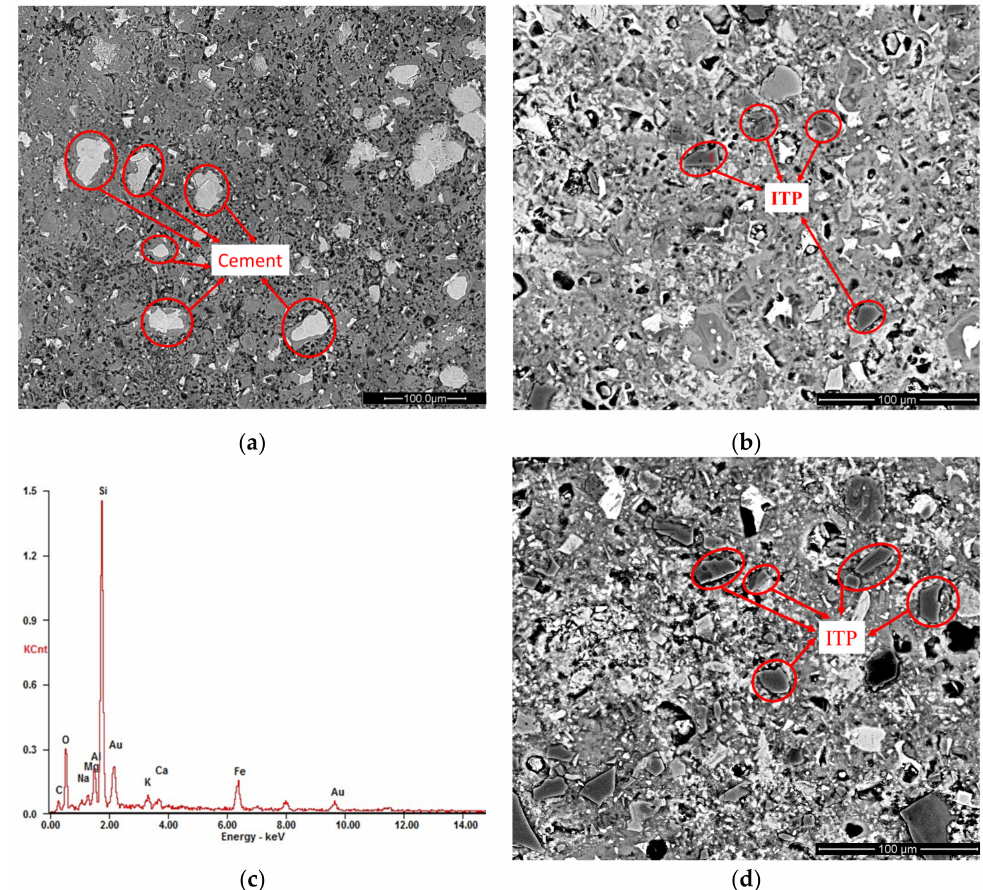
Figure 10. BSE images of cement-ITP hardened pastes cured for 365 days at 20 ◦ C: ( a ) TP0; ( b ) TP20; ( c ) EDS of point “1” in Figure 11b; ( d )